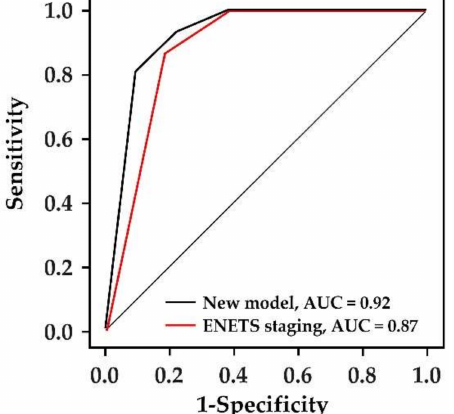
Figure 3. Receiver operating characteristic curve for predicting aggressiveness of non-functioning pancreatic neuroendocrine neoplasms. Although it was not statistically significant, the new model had a higher value of area under the curve than the ENETS staging system ( p =